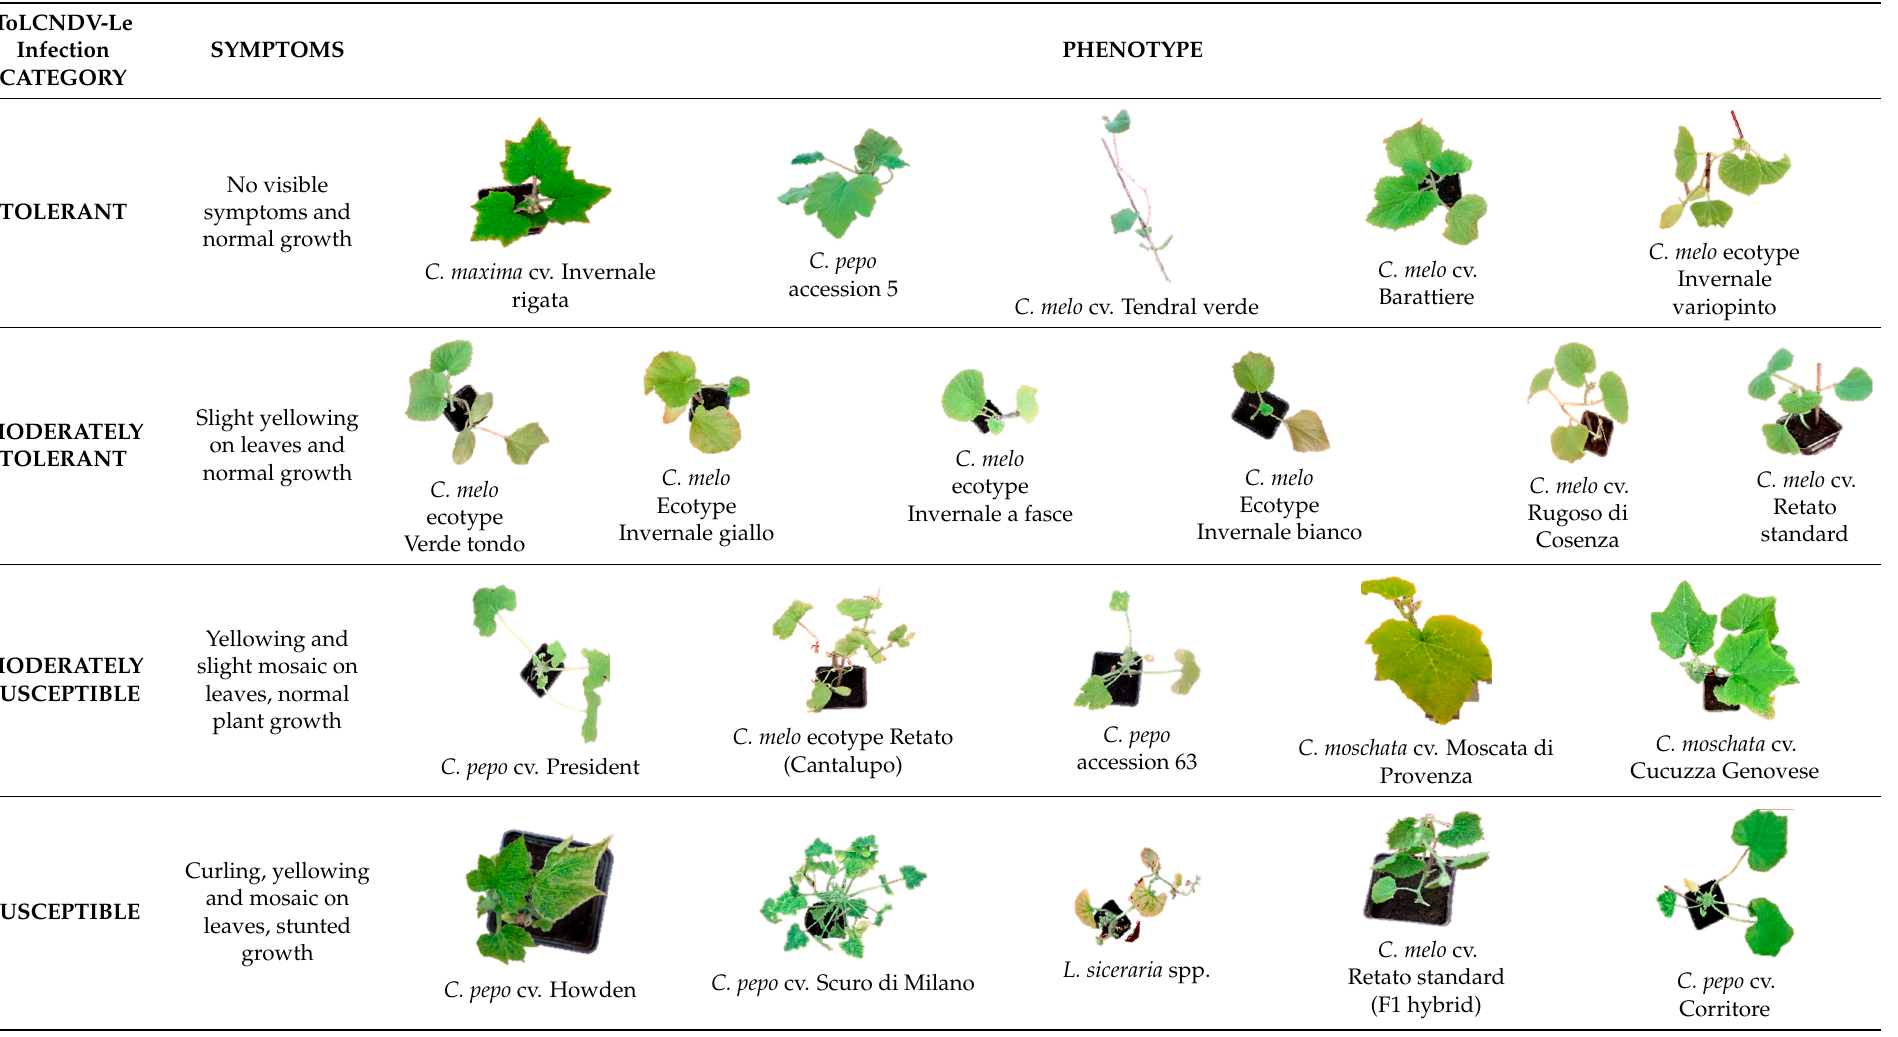
5 of 15 Corritore, Howden, and Scuro di Milano; L. siceraria spp. C. melo ecotypes Invernale bianco and Invernale variopinto. C. melo cvs. Retato standard (no F1 commercial hybrid), Invernale giallo, Invernale a fasce, Rugoso di Cosenza, and Verde tondo showed very mild systemic symptoms and underwent recovery by 21 dpi so that no symptoms could be observed in the new vegetation at 28 dpi. Symptomless infections during the whole time period of the assay were observed in C. maxima cv. Invernale rigata, C. melo cv. Barattiere, C. pepo accession 5, and cv. Tendral (Table 1). Table 1. Visual evaluation of symptoms induced by ToLCNDV-Le in Cucurbita , Cucumis, and Lage-